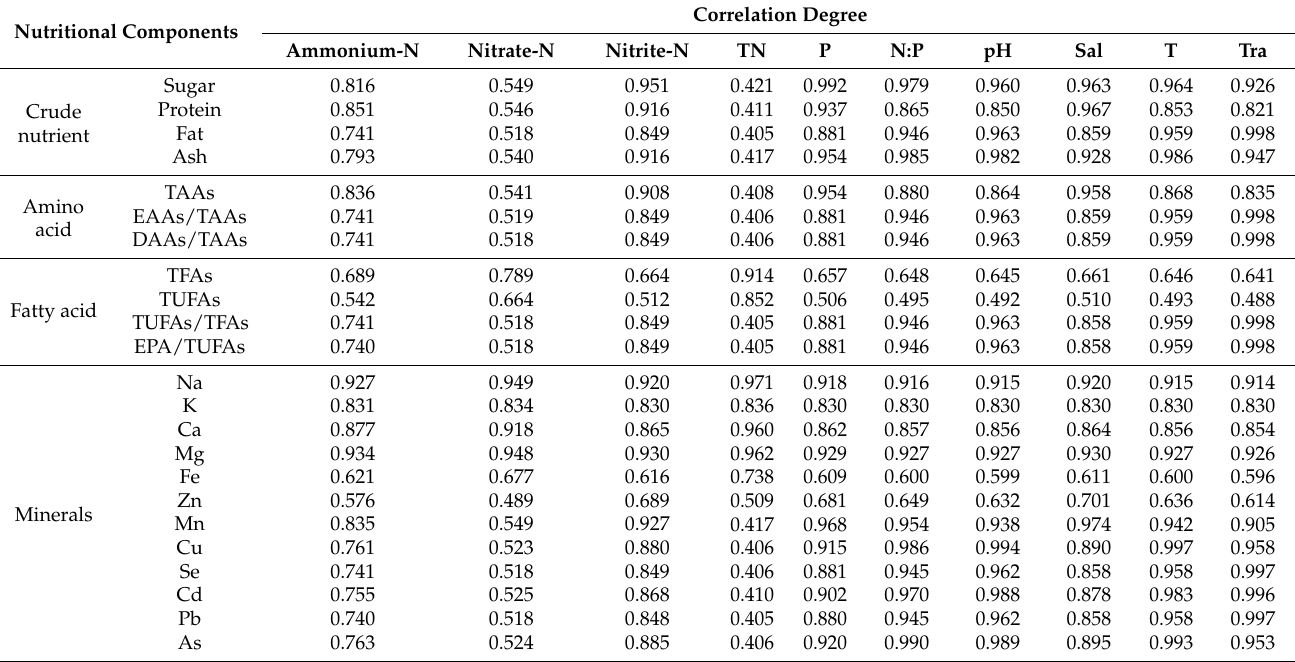
Table 6. Gray correlation coefficients between the contents of crude nutrient, amino acid, fatty acid, and minerals in N. yezoensis and related ecological factors. The abbreviations were the same in Table 1.